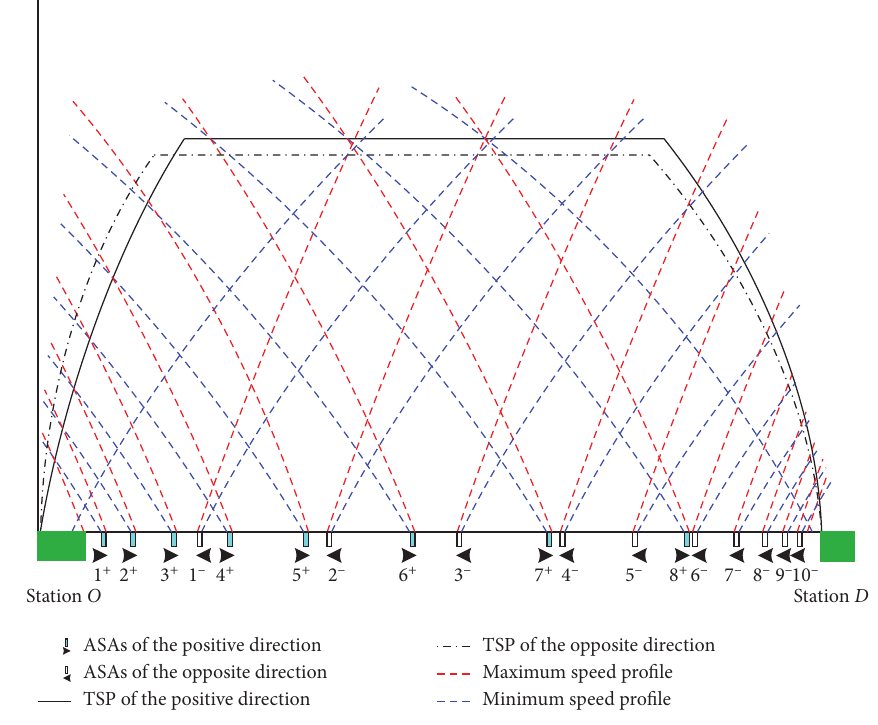
Figure 9: ASA layout considering the two directions separately for the ideal condition.